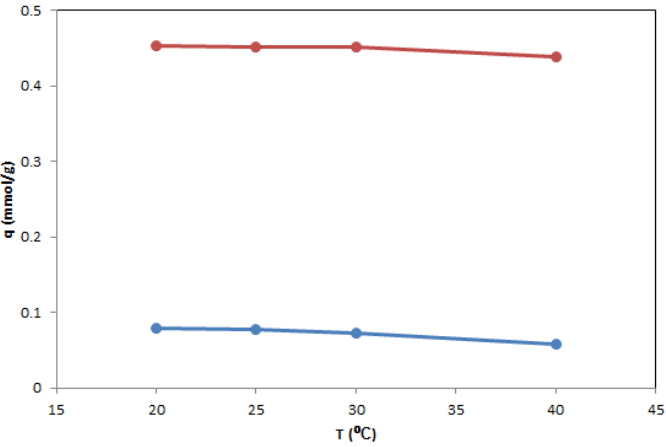
Fig. 9 . Fig. 9. Diagram of equilibrium uranium ion adsorption as a function of